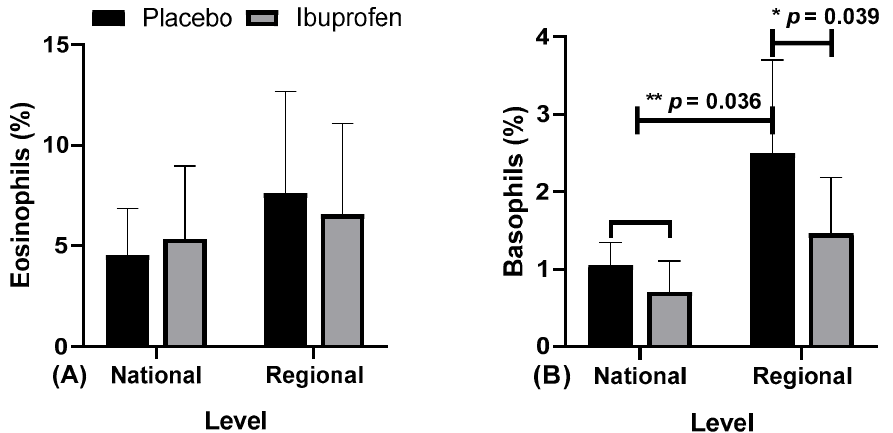
Figure 6. Blood markers: ( A ) eosinophils and ( B ) basophils in the use of placebo (PLA) and ibuprofen (IBU) at regional and national levels of training. * and ** p < 0.05.